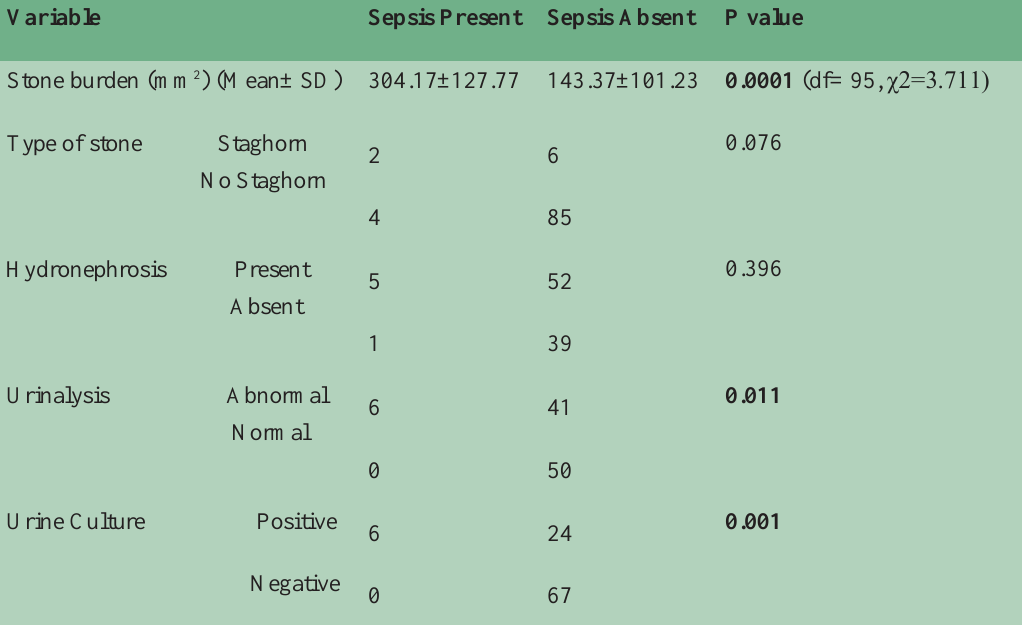
Table 3: Pre-operative parameters in relation to Sepsis (N=97) Variable Sepsis Present Sepsis Absent P value Stone burden (mm 2 ) (Mean± SD) Type of stone